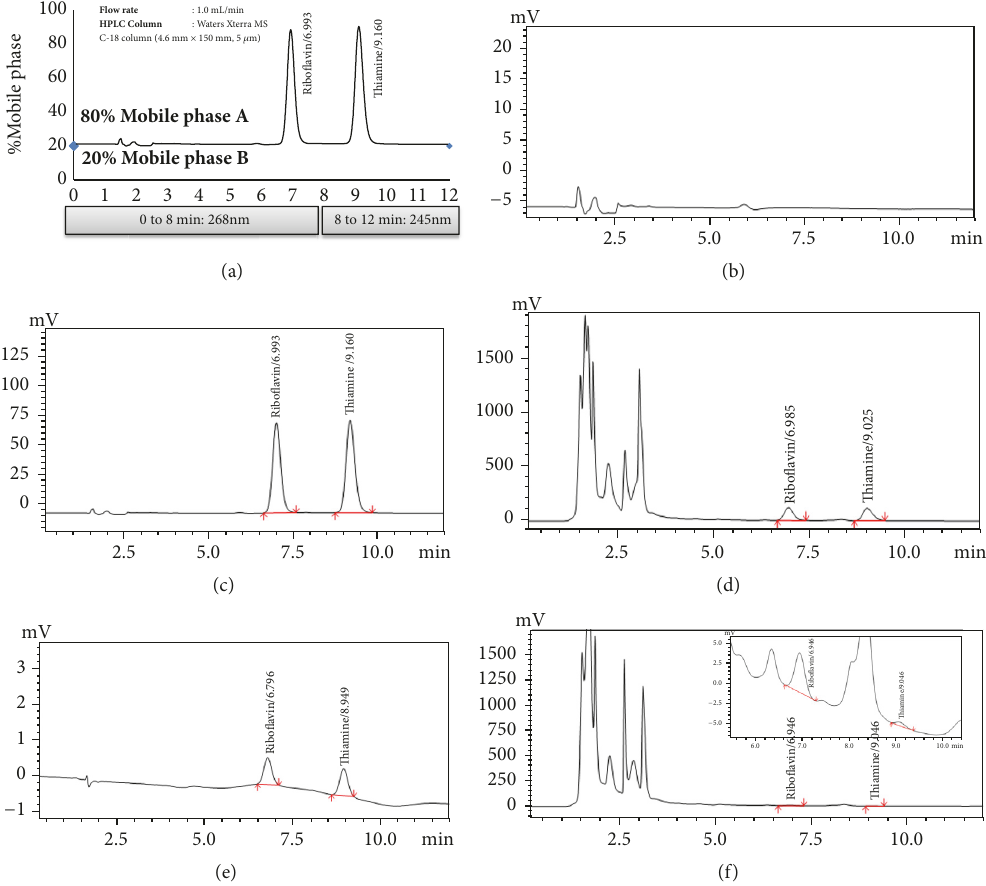
Figure 5: HPLC chromatograms obtained from Shimadzu prominence HPLC system with a UV-Vis detector (SPD-20AC) in method validation studies: (a) isocraticelutionparameters,(b) diluting solution, (c)referencestandards solution, (d) testsample spiked with reference standards, (e) LOD solution, and (f) test sample (Shitaki